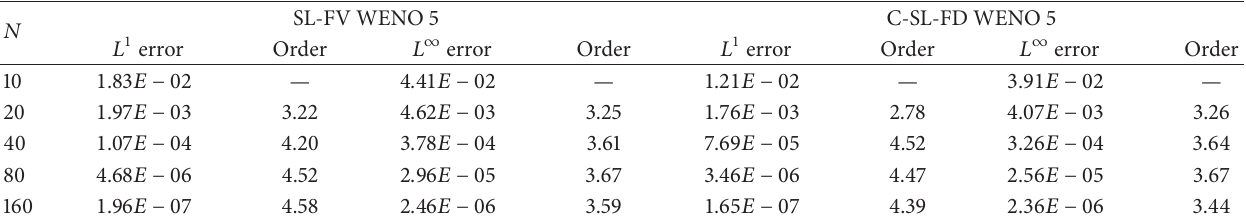
Table 2: Left: SL-FV WENO 5 scheme, right: C-SL-FD WENO 5 scheme for Example 1 on a uniform mesh of 𝑁 cells at 𝑡 = 0.5 , CFL = 5.9, and 𝜀 = 10 −6 . 𝑁 SL-FV WENO 5